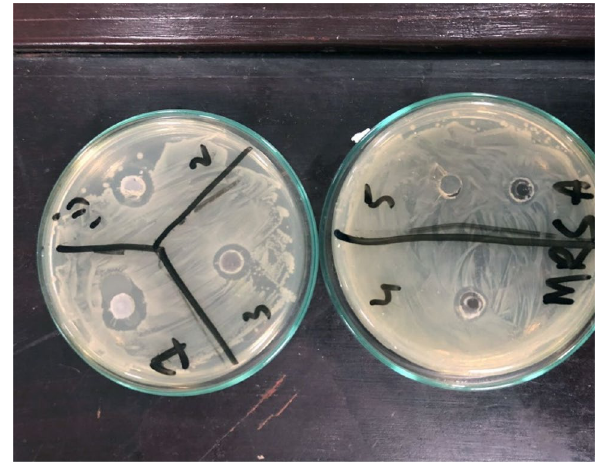
Fig. 14 Zone of inhibition of